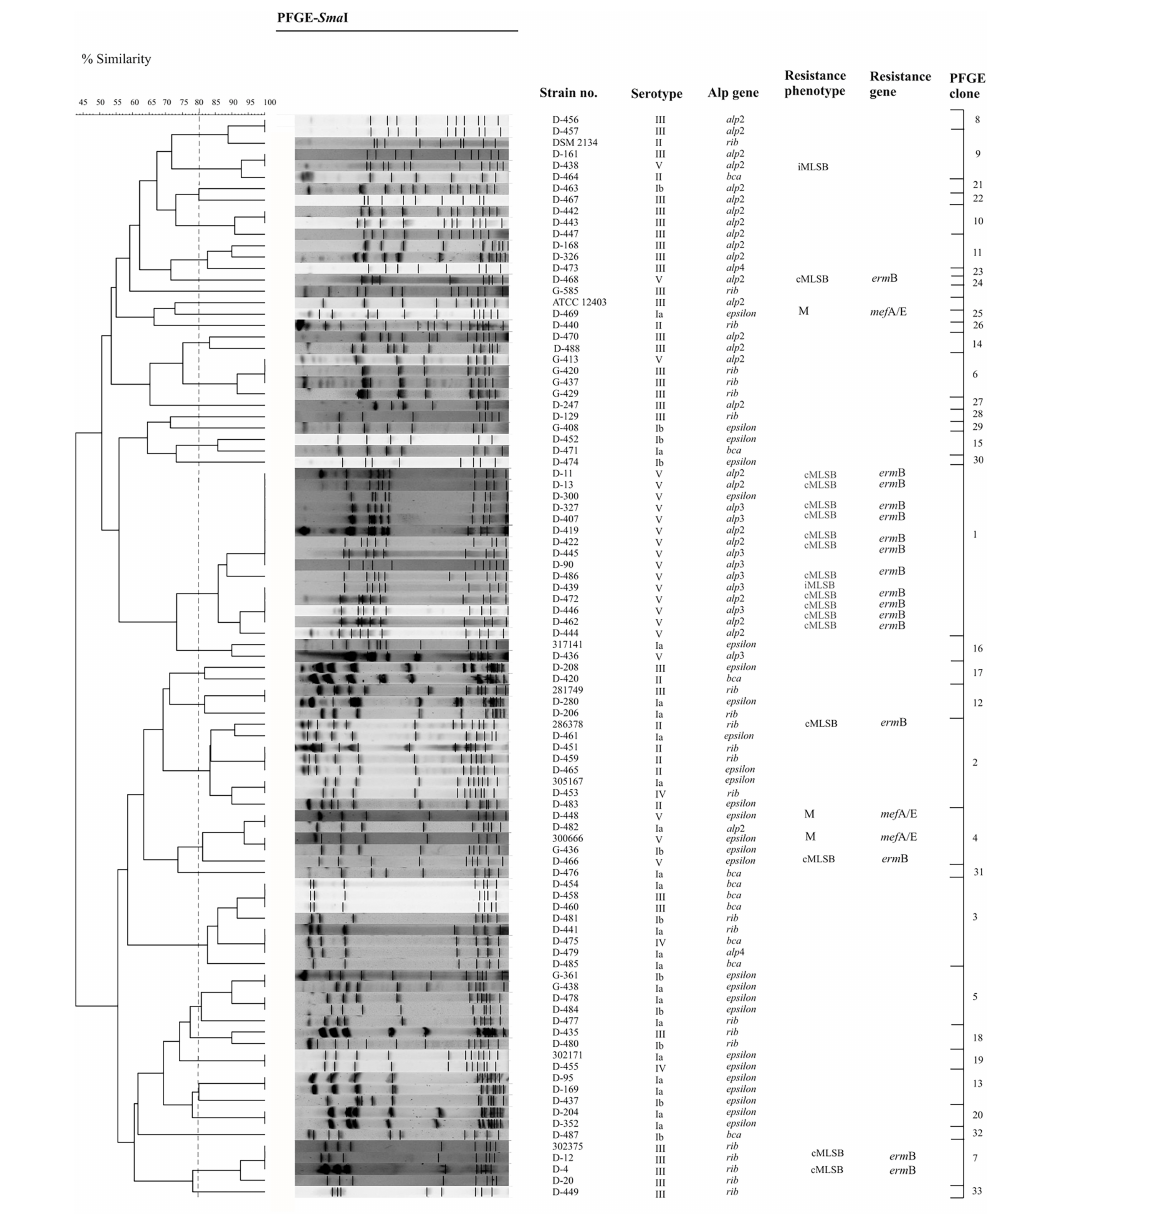
FIGURE 2 | Dendrogram demonstrating the genetic relationship between 94 GBS isolates after restriction with Sma I enzyme. DNA fragments were separated by PFGE using the CHEF DR R (cid:13) II system. PFGE profiles were compared according to their percentage of similarity, estimated by the Jaccard coefficient and clustered by UPGMA using GelCompar II v.6.5 software. PFGE settings: optimization, 0.5%; tolerance, 3%. Strains belonging to the same group (PFGE clone) were clustered at a level of 80% similarity (dashed vertical